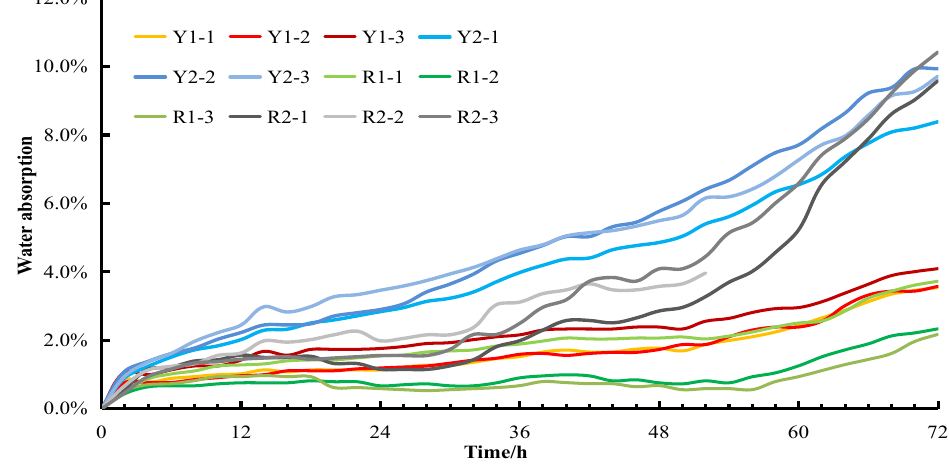
Figure 4. Total curves of water storage rate of rock specimens in 72 h.